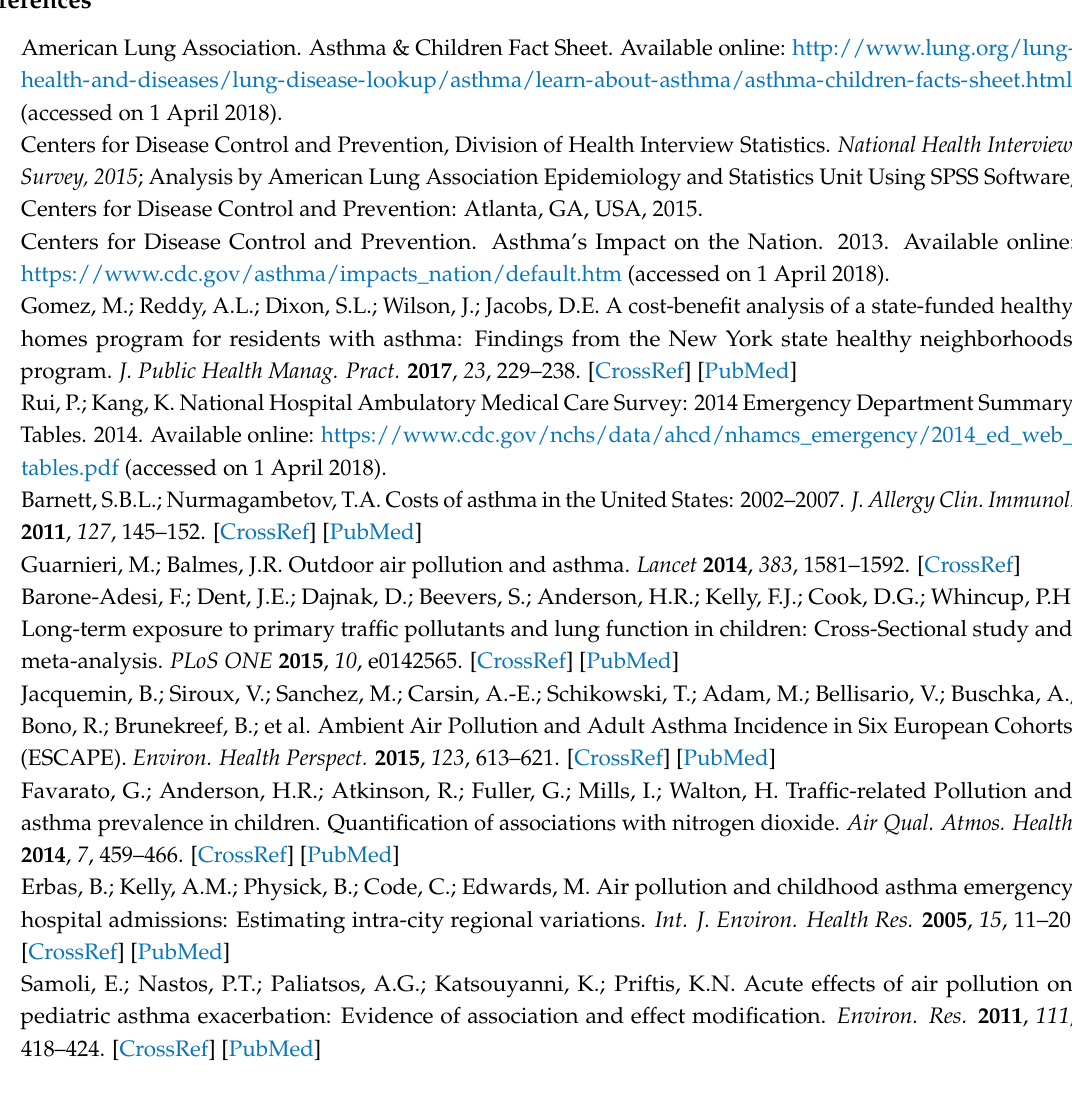
Table S1: SD-rescaled effects of early-life NO 2 exposure on childhood asthma, PSID-CDS, 1990–2014, Table S2: SD-rescaled effects of early-life PM 2.5 exposure on childhood asthma, PSID-CDS, 1990–2014, Table S3: SD-rescaled effects of early-life pollution exposure on childhood asthma by neighborhood poverty, PSID-CDS, 1990–2014. Author Contributions: N.K.W., S.T., A.H. and K.C. conceived and designed the research; N.K.W., A.H. and